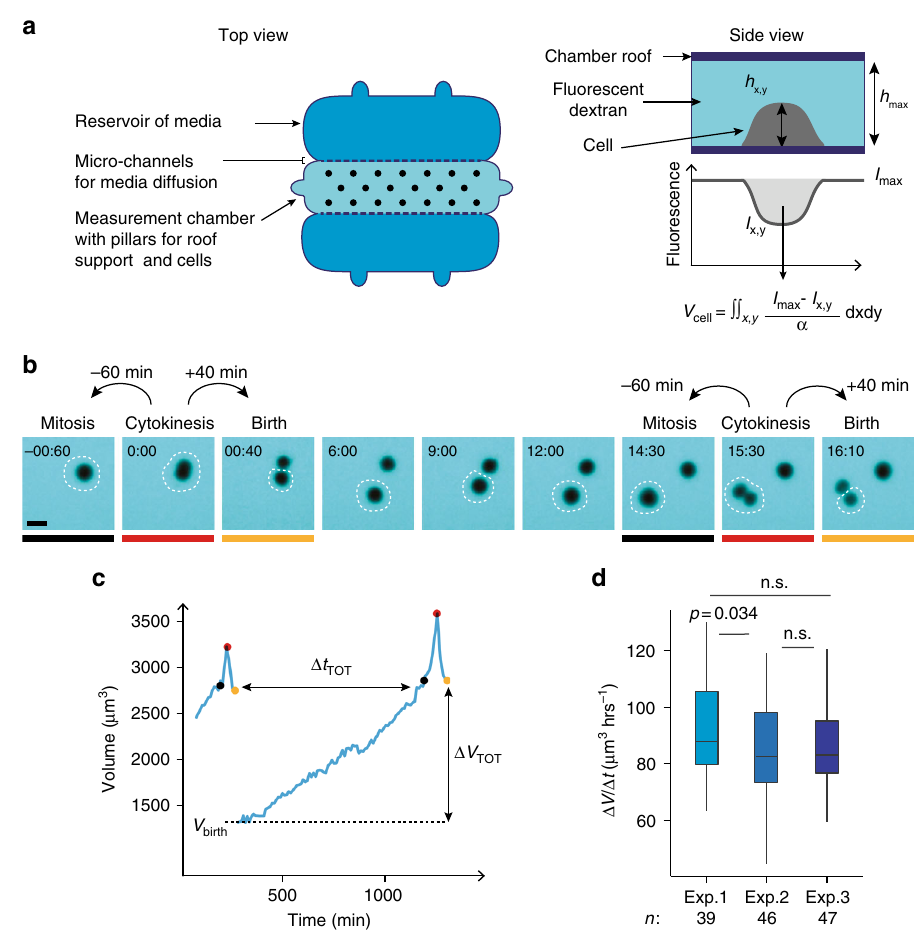
Fig. 1 Single-cell volume tracking over entire cell division cycles. a Principle of the fl uorescence exclusion volume measurement method (FXm). Left: top view of the measurement chamber used for 50 h long time-lapse acquisitions (see Methods). Right: side view of the chamber and principle of the measurement. Fluorescence intensity at a point I x,y of the cell is proportional to the height of the chamber minus the height h x,y of the cell at this point. Fluorescence intensity I max is the intensity under the known height of the chamber roof h max , where no object excludes the fl uorescence. Integration of fl uorescence intensity over the cell area gives the cell volume V fl uorescence intensity signal α = ( I − I h cell after calibrating the max min )/ max (see Methods). b Sequential images of a HT29-wt cell acquired for FXm. Mitosis and birth are de fi ned as the time points 60 min before and 40 min after cytokinesis respectively (see Methods). The white dashed circle indicates the cell measured in Fig. 1c, the colored lines indicate the time points highlighted by circles of the same color in Fig. 1c. Time is in hours:minutes. Scale bar is 20 µ m. c Single HT29-wt cell growth trajectory (volume as a function of time) and key measurement points (see Methods). The time points shown in Fig. 1b and underlined in gray, red, or yellow are indicated by points of matching colors on the curve: the gray points correspond to volume at mitotic entry, the red points correspond to volume at cytokinesis and the yellow points to volume at birth. Δ t TOT is the total duration of the cell division cycle from birth to mitosis and Δ t TOT is the total added volume. d Average growth speed for three independent experiments with HT29-wt cells. n = 39 (exp. 1), n = 46 (exp. 2), n = 47 (exp. 3). The p -values are the result of a pairwise t test comparing